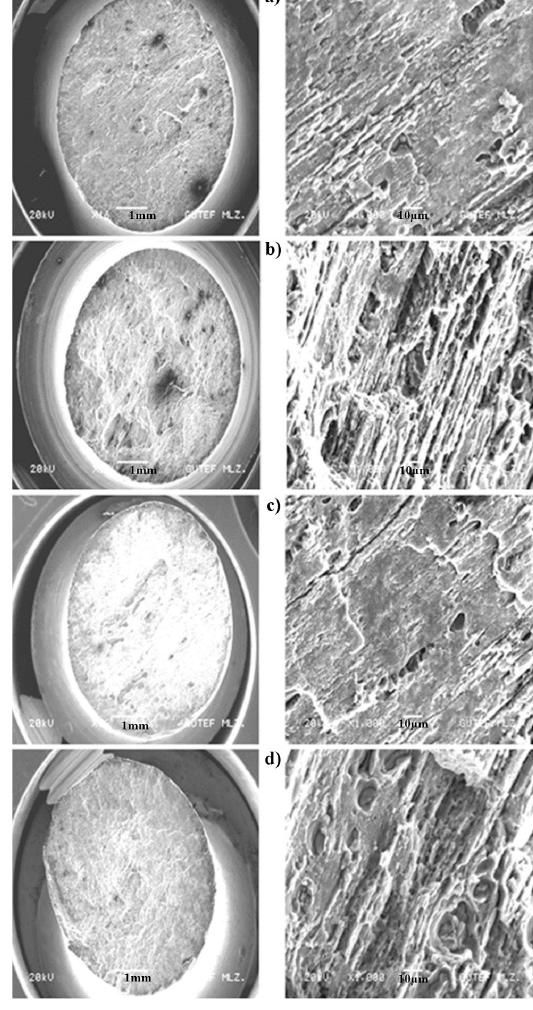
Figure 9. Fracture surface of tensile test samples; a) SHTWQ b) SHTWQ aged 140 °C for 2 h, c) SHTWQ aged 140 °C for 12h, d) SHTWQ aged 140 °C for 96